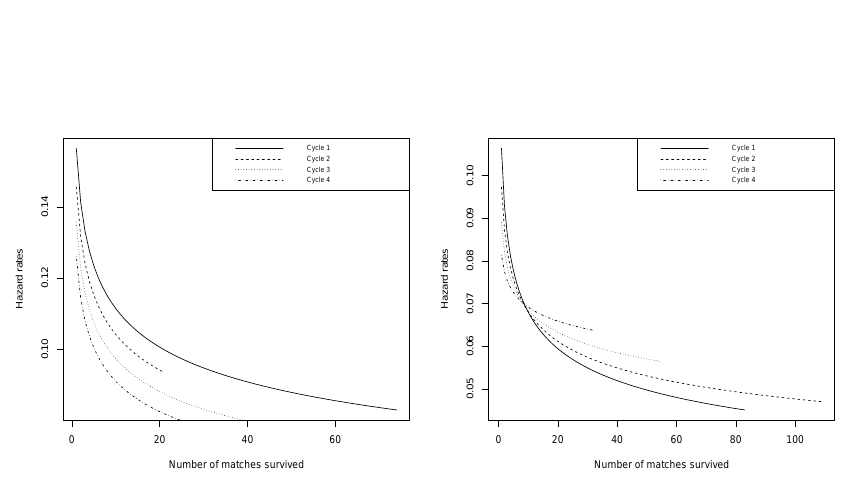
Figure 4 – Batsmans’ hazard curves for the events dropped (left panel) and selected (right panel).